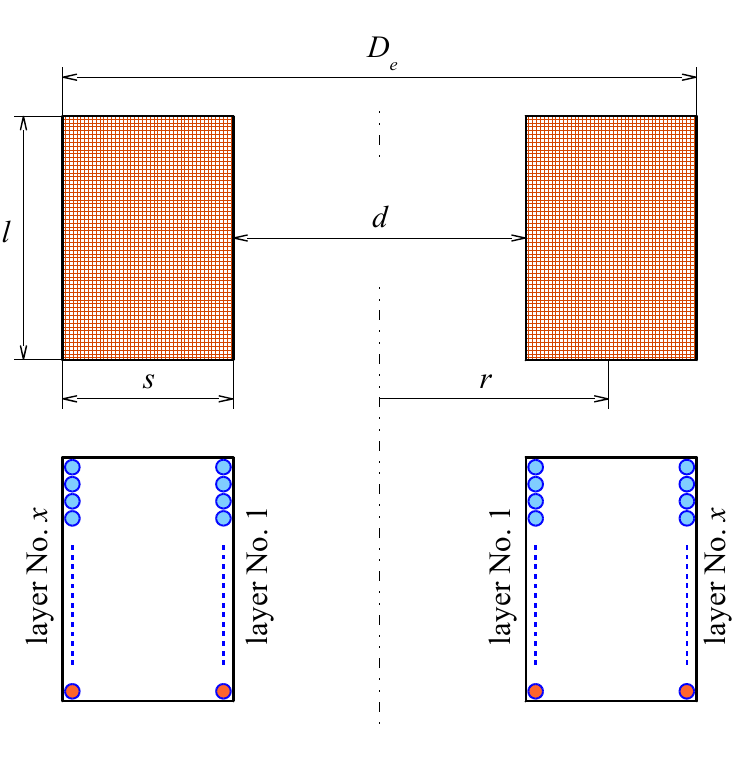
Figure 3. Basic design outline of the filter.